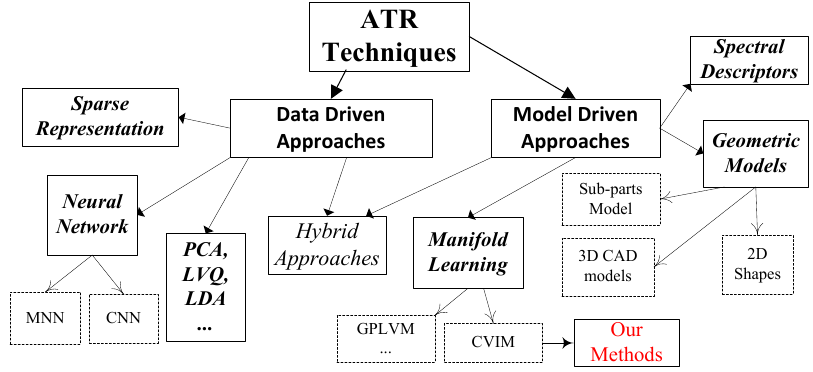
Figure 2. A taxonomy of ATR methods. MNN (modular neural network); CNN (convolutional neural network); LVQ (learning vector quantization); GPLVM (Gaussian process latent variable model); CVIM (couplet of view and identity